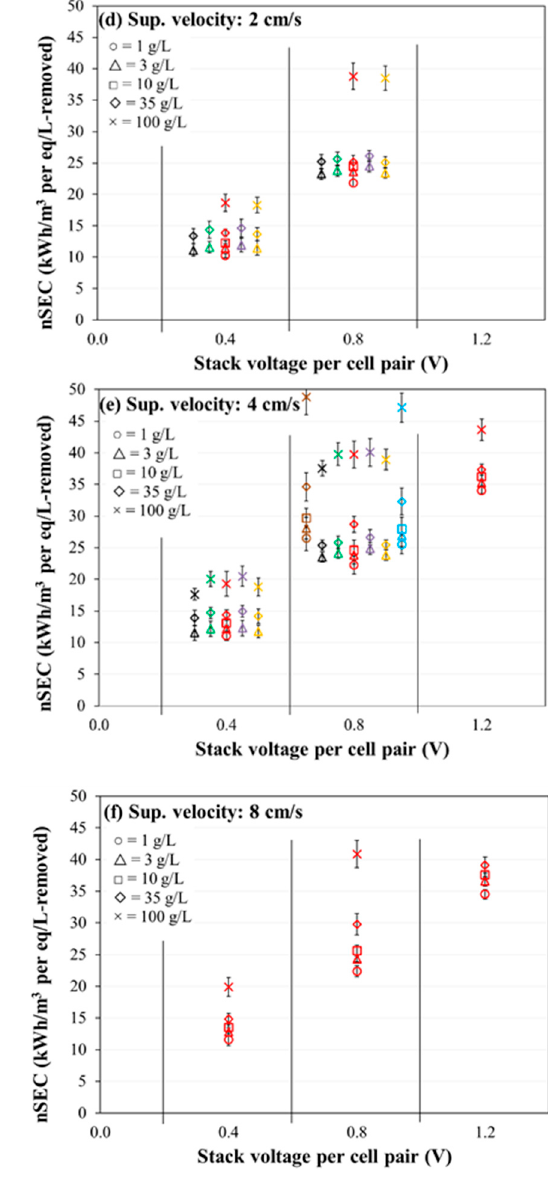
Figure 5. Salinity reduction ( a – c ) and normalized specific energy consumption (nSEC) ( d – f ) of diluate stream after 60 min of treatment. Experimental conditions: Five cell-pairs stack ;1–100 g/L NaCl initial diluate and concentrate solutions (500 mL each); 2, 4, and 8 cm/s superficial velocity of feed solution; 0.4, 0.8, and 1.2 V/cell-pair constant applied stack voltage; 0.1 M (14.2 g/L) Na 2 SO 4 electrode rinse solution; and 3 kPa transmembrane pressure. Representation of membranes, left to right: Brown: AMX/Polycarb, Black: Ralex CMH-PES/AMH-PES, Green: PCA PCSK/PCSA, Red: Neosepta AMX/CMX, Purple: Fujifilm Type 1 AEM/CEM, Orange: SUEZ AR204/CR67, Blue: AMX/SandiaCEM.